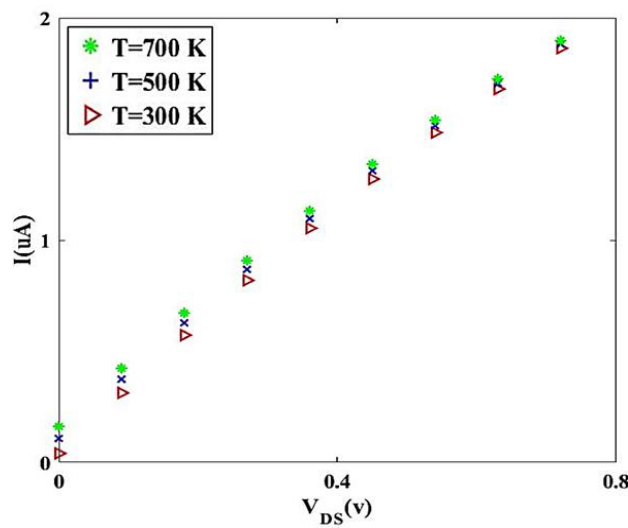
Figure 11. I-V characteristic for diverse values of temperature.